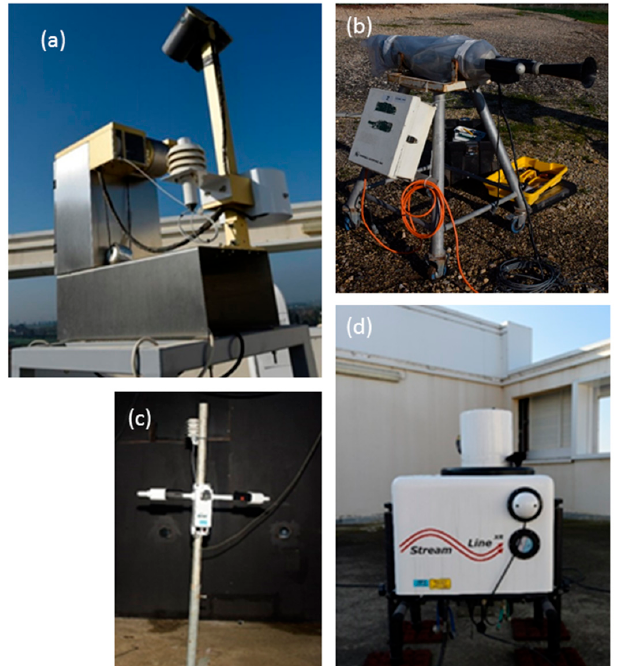
Figure 4. Field-experiment instrumentation: ( a ) Sky imager [ASIS1i, SOLOMIRUS, Colorado Springs, Colorado, USA]. ( b ) Droplet-sizes measurements [FSSP-100, PMS, Boulder, Colorado, USA]. ( c ) Visibility-range sensor [SWS250, Biral, Bristol, UK]. ( d ) Doppler Lidar [StreamLine XR, Halo photonics, Leigh, UK].